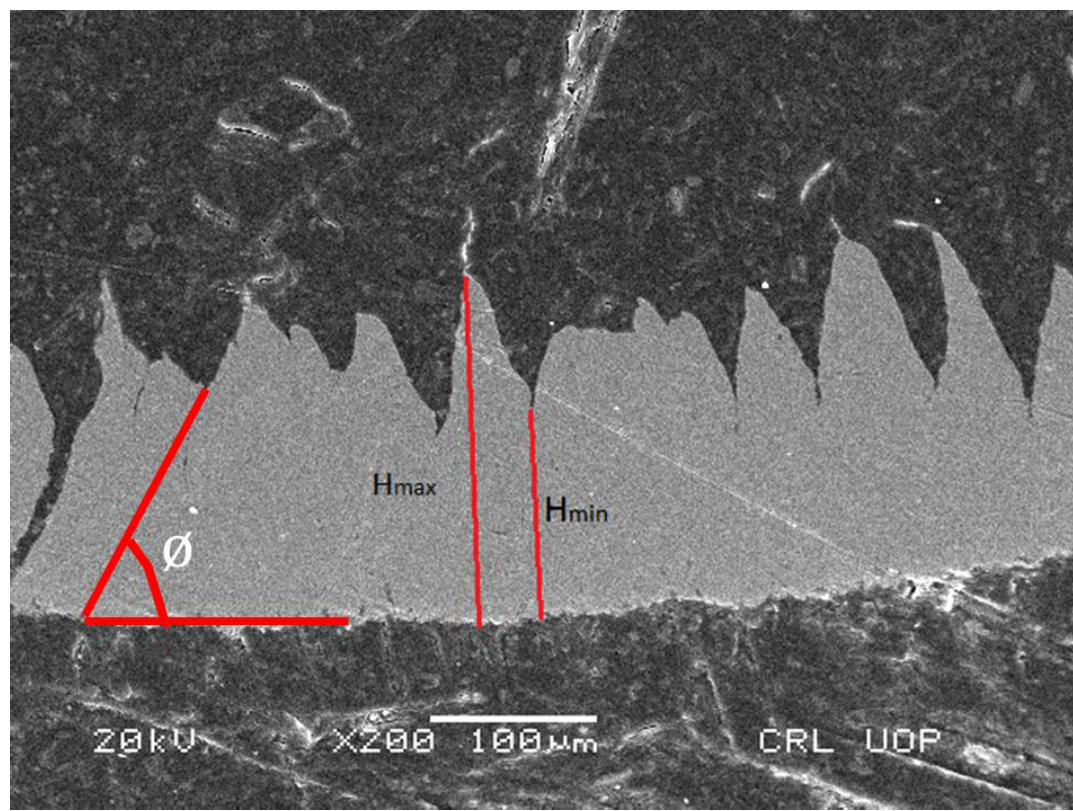
Figure 17. SEM image of the analyzed chip.